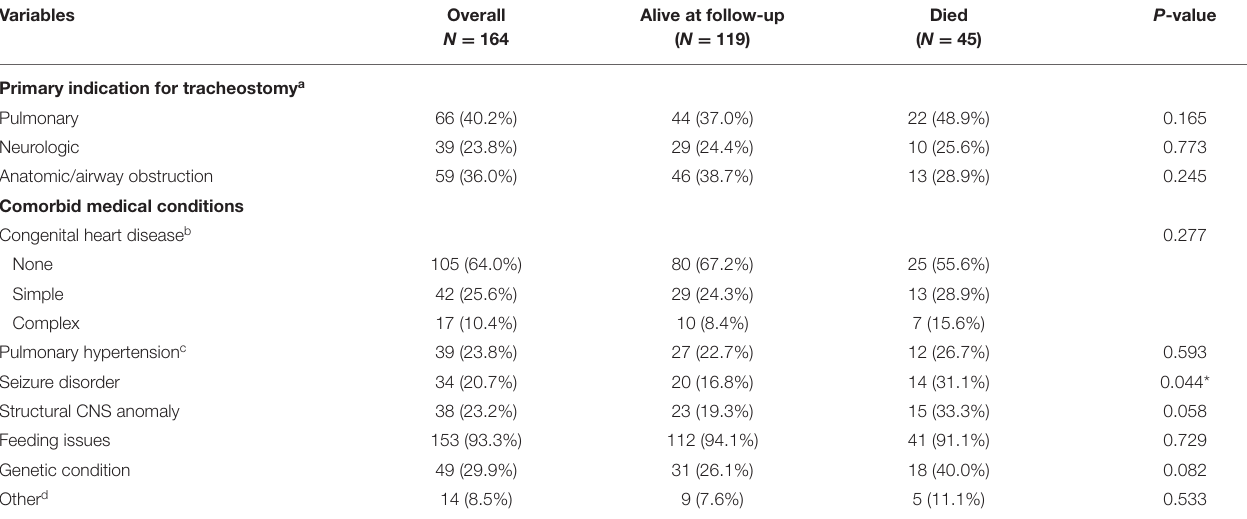
TABLE 2 | Clinical characteristics and